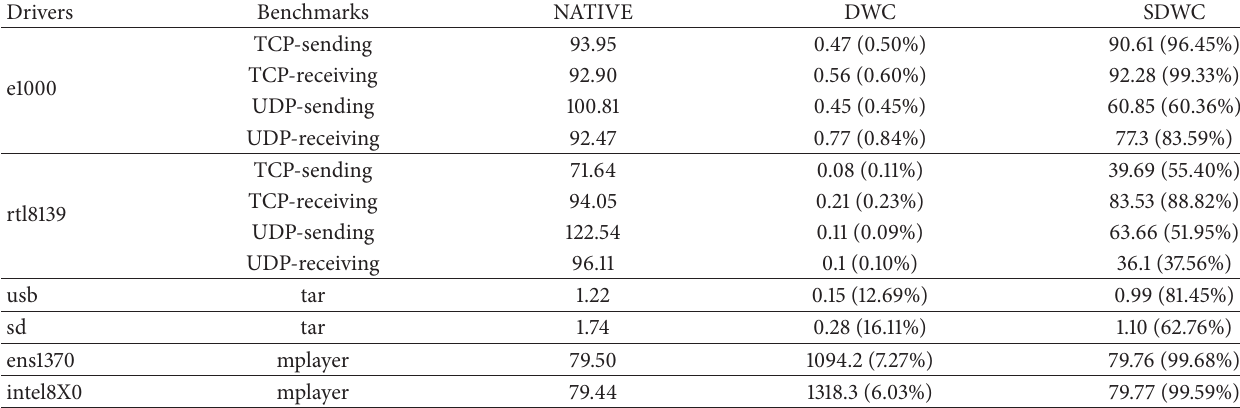
Table 1: The throughput (MB/s) or running time (s) of drivers, in the bracket is the relative performance; the performance of ens1370 and intel8x0 is running time; others are throughput.